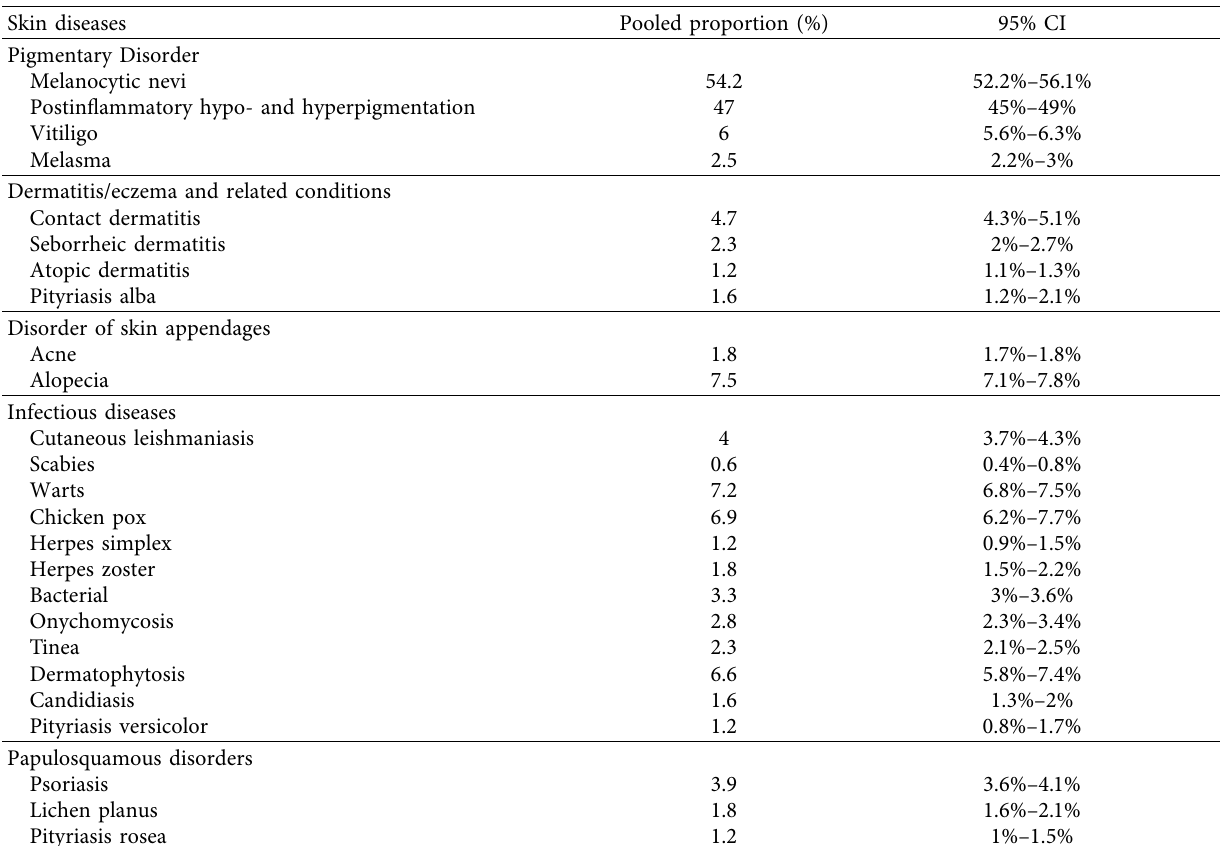
Figure 2: Forest plot of the pooled proportion for the prevalence of (a) pigmentary disorders, (b) dermatitis, (c) infectious diseases, (d) disorders of skin appendages, and (e) papulosquamous disorders. Table 3: Pooled proportion of the skin diseases pattern in Saudi